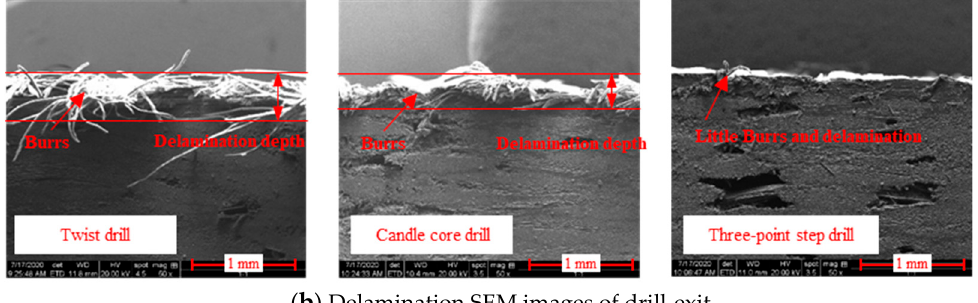
Figure 8. Microstructures and SEM images of the drill-exit. ( a ) Microstructures of the exit by Alicona; ( b ) Delamination SEM images of drill-exit.